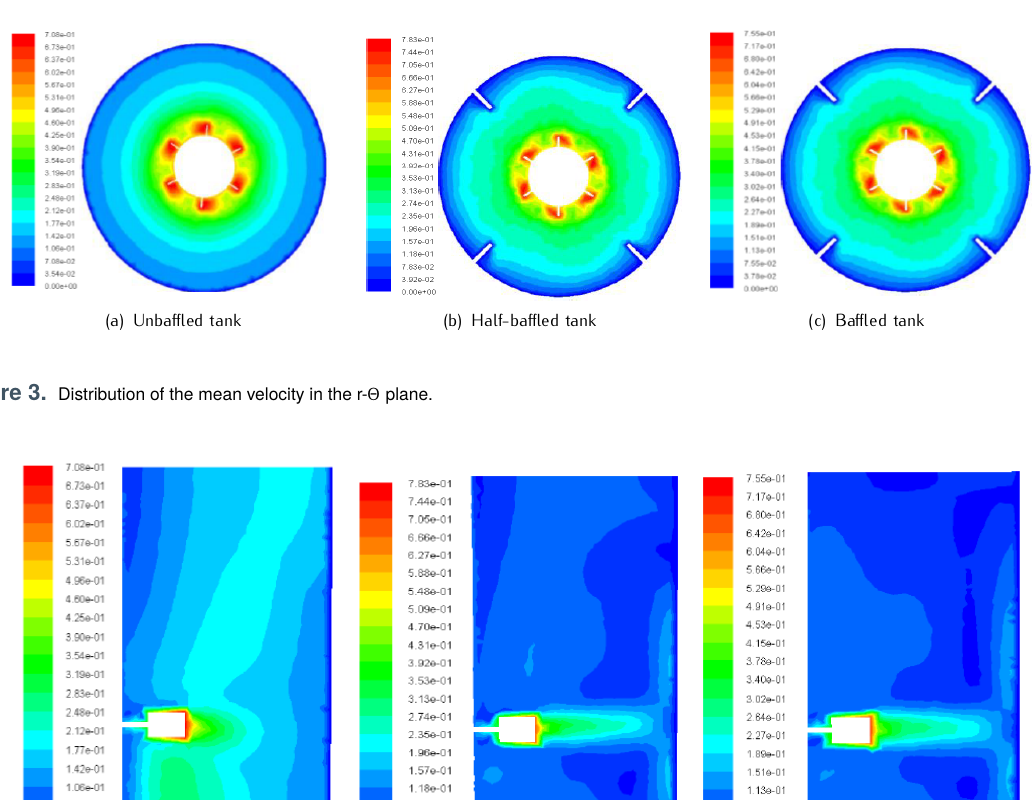
Figure 4. Distribution of the mean velocity in the r-z plane.